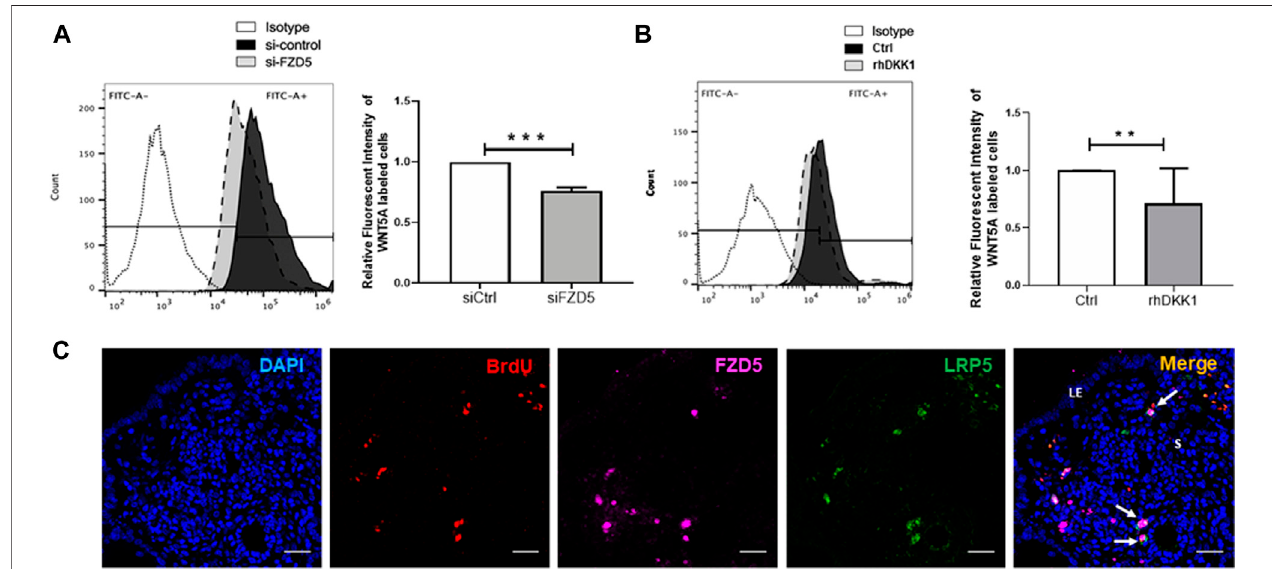
FIGURE 6 | Bound signal of WNT5A with eMSC after FZD5 gene silencing and blocking of LRP5. (A) Representative images showing the peak shift of the fl uorescent intensity in eMSC after transfection with control siRNA (siCtrl) (black) and siFZD5 (gray). Bar graph showing the relative fl uorescent intensity of eMSC after transfectionwithsiFZD5(n=7). (B) Representativeimagesshowingthepeakshiftofthe fl uorescentintensityineMSCwith(gray)orwithout(black)treatmentwith0.1 μ g/ ml rhDKK1 protein. Bar graph showing the relative fl uorescent intensity of eMSC after treatment with 0.1 μ g/ml rhDKK1 (n = 7). (C) Representative immuno fl uorescenceimagesshowingthecoexpressionofFZD5(pink)andLRP5(green)inlabelretainingstromalcells(LRSCs:BrdU + cells,red)at6weekschase(white arrow). Scale bar: 20 µm. Results are presented as mean ± SD, ** p < 0.01, *** p < 0.001. Abbreviations: BrdU, bromodeoxyuridine; DKK-1, Dickkopf-1; eMSC, endometrial mesenchymal stem-like cells; FZD, frizzled; LE, luminal epithelium; s, stroma.